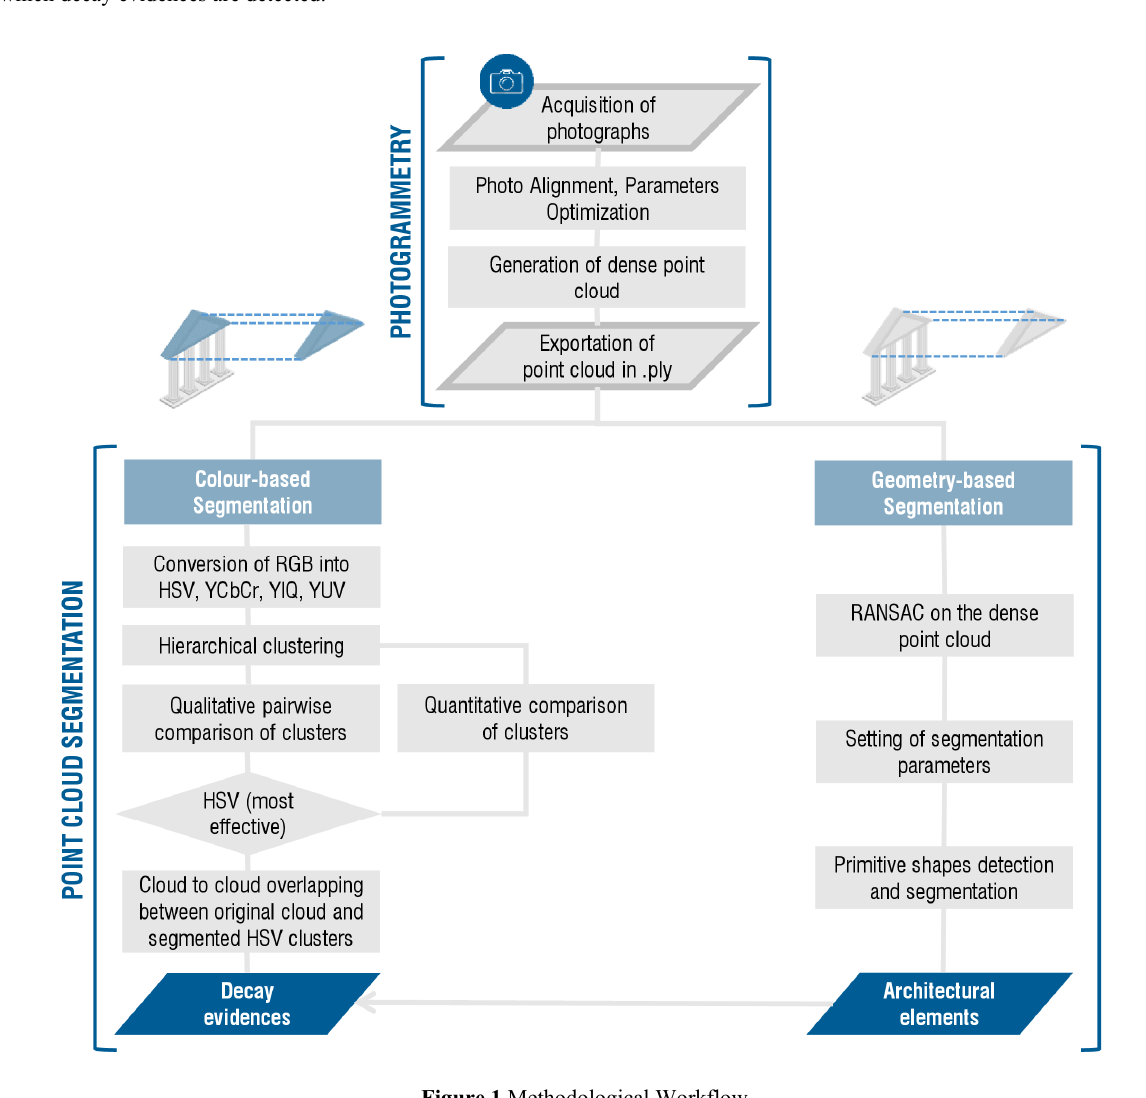
Figure 1 Methodological